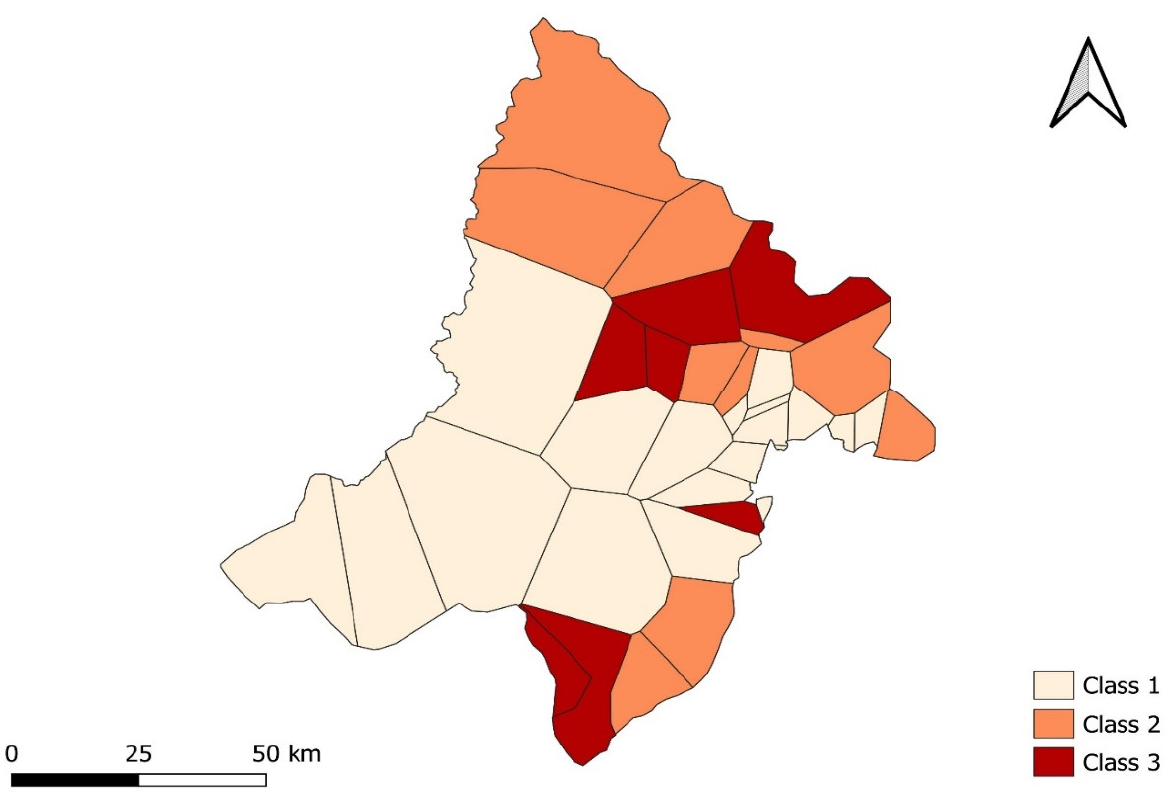
Figure 6. Map of health areas classified according to level of malaria risk. Class 1 corresponds to a low level of malaria risk, Class 2 to a high level of malaria risk, and Class 3 to a moderate level of malaria risk. Table 5. Classes of malaria risk according to the number of health areas and to meteorological and environmental